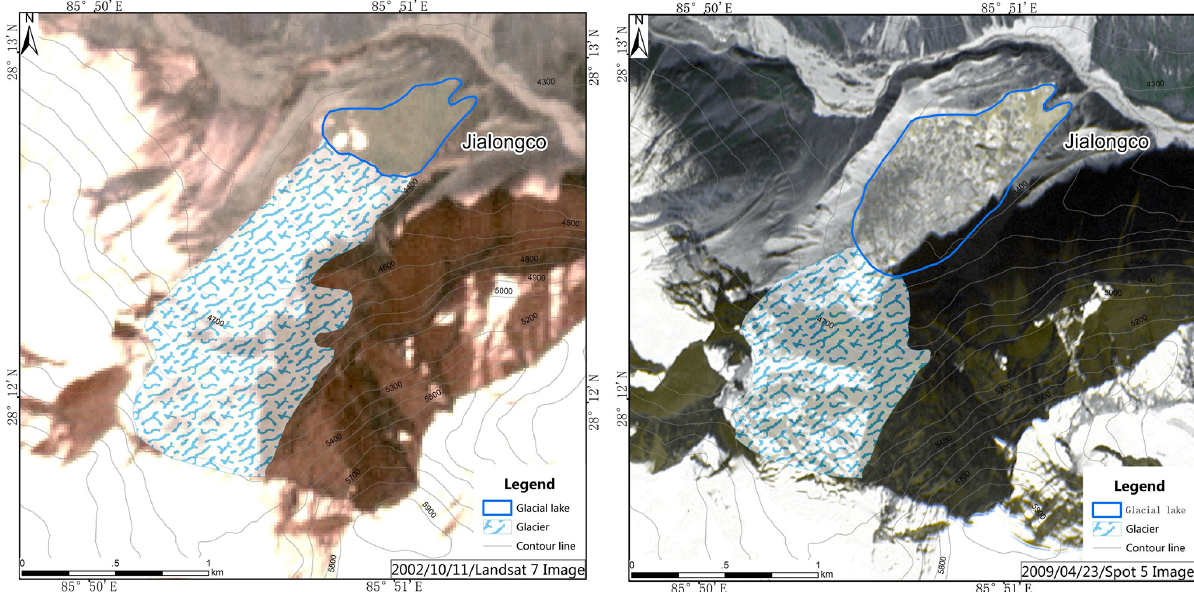
Figure 10. The Rapid expansion in the area of the Jialongco Lake due to glacial loss (2002–2009).